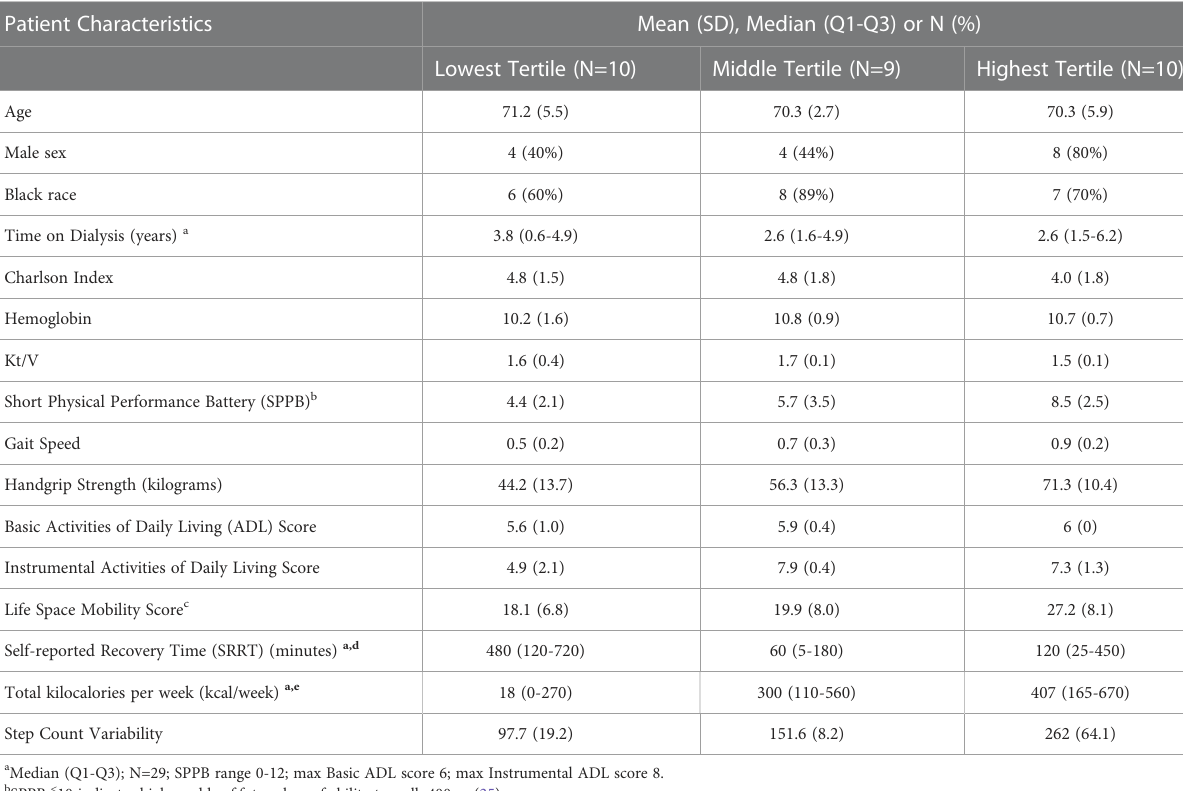
TABLE 1 Baseline characteristics of